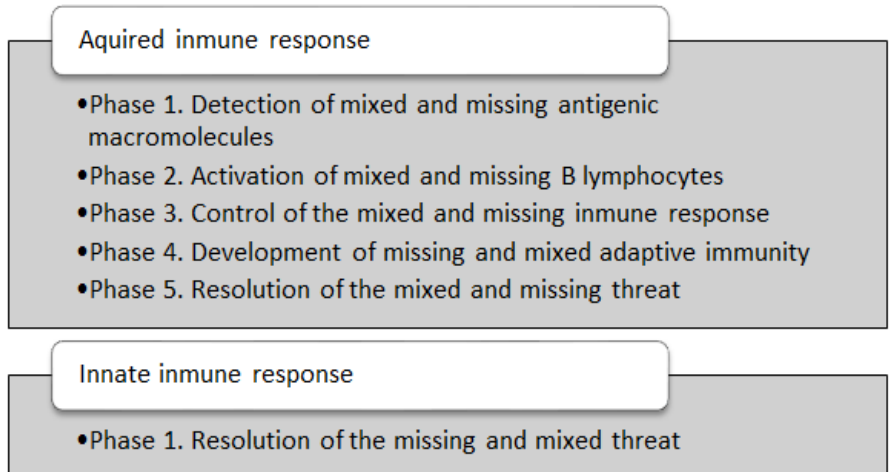
Figure 2. Immune response in the AISAC-MMD model.